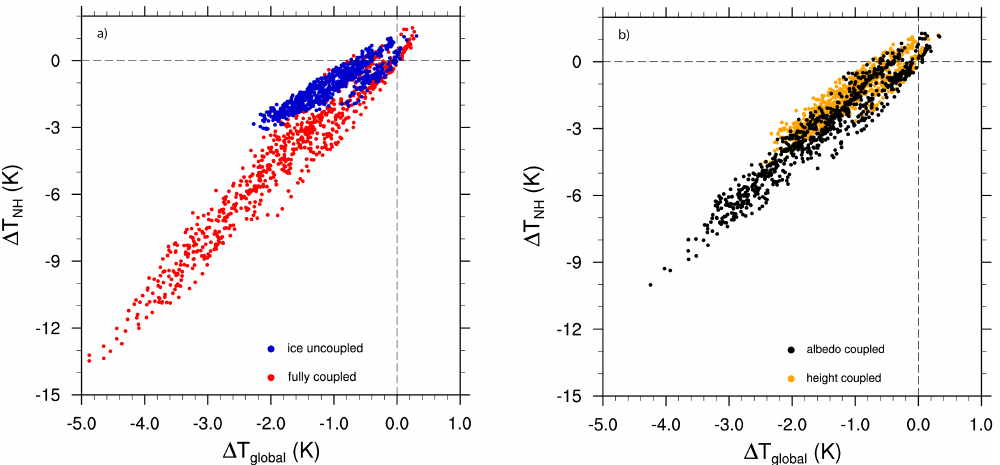
Figure 10. (a) Relation between NH and global temperature anomaly from PI for the fully coupled reference run (red), and the ice-uncoupled run (blue). (b) Relation of NH to global temperature anomaly for the albedo-coupled run (black) and the height-coupled run